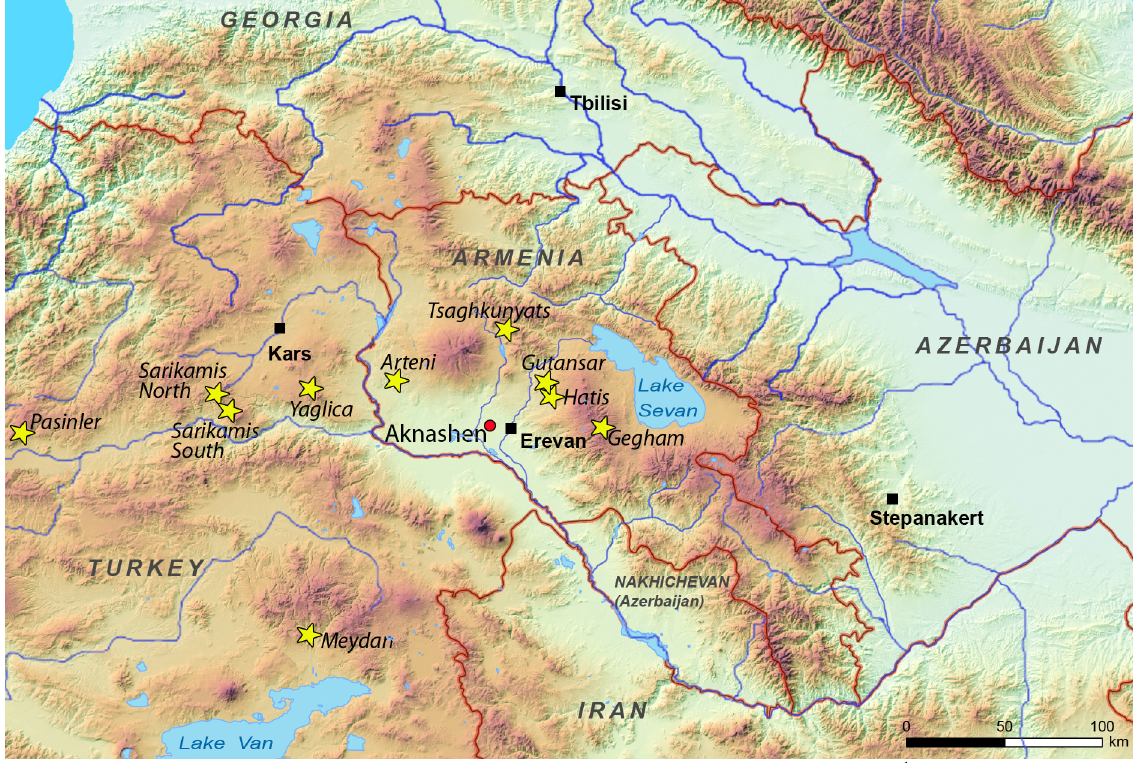
Figure 1. Localisation du village d’Aknashen et des sources d’obsidienne utilisées. (Carte préparée par C. Chataigner, MOM, U. Lyon 2.) Figure 1. Location of the village of Aknashen and obsidian sources used. (Map prepared by C. Chataigner, MOM, U. Lyon